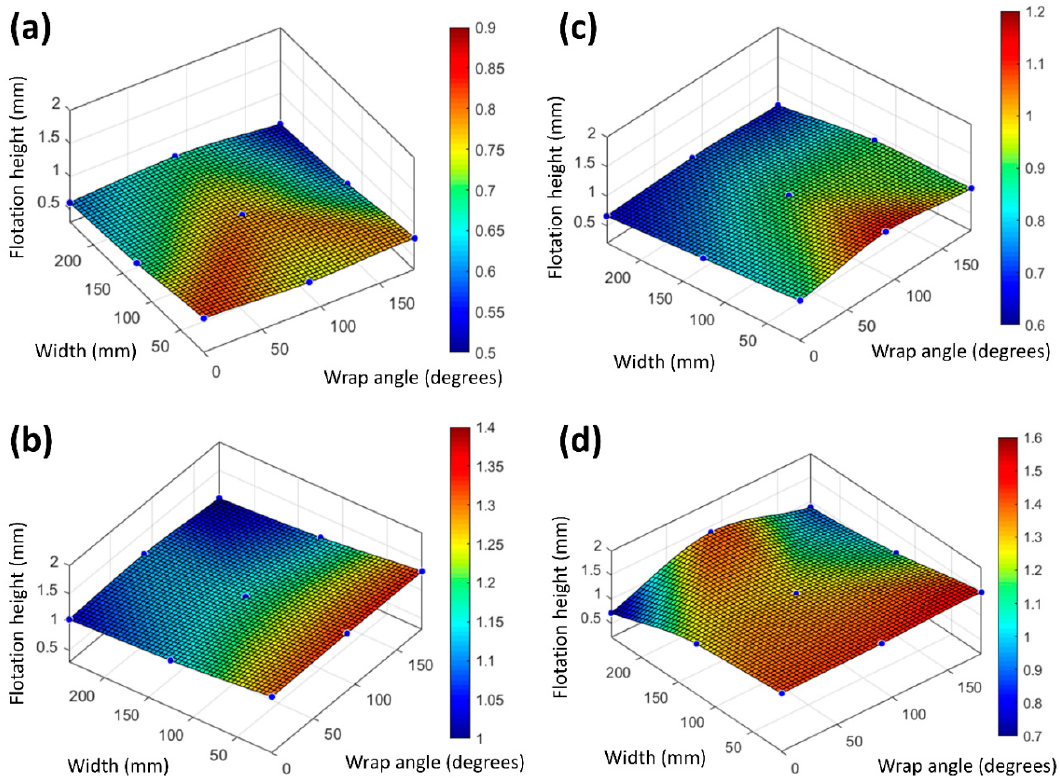
Figure 9. Measured flotation heights as a function of operating velocity and blower frequency. A width of 0 mm refers to the right area and a wrap angle of 0 degrees refers to the inlet. The velocity and blower frequency were respectively ( a ) 10 m / min and 25 Hz, ( b ) 10 m / min and 35 Hz, ( c ) 15 m / min and 25 Hz, and ( d ) 15 m / min and 35